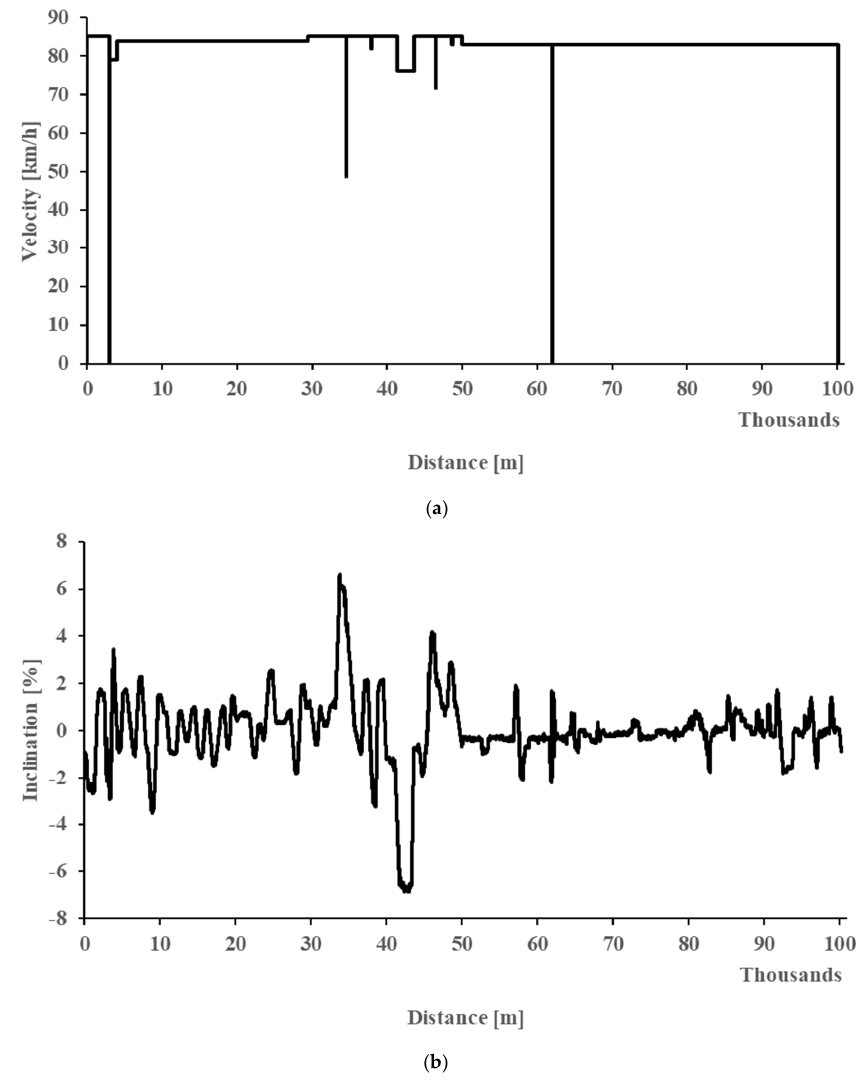
Figure 4. The ( a ) velocity profiles and ( b ) road inclination variations in the Long-haul driving cy- cle [26,27].